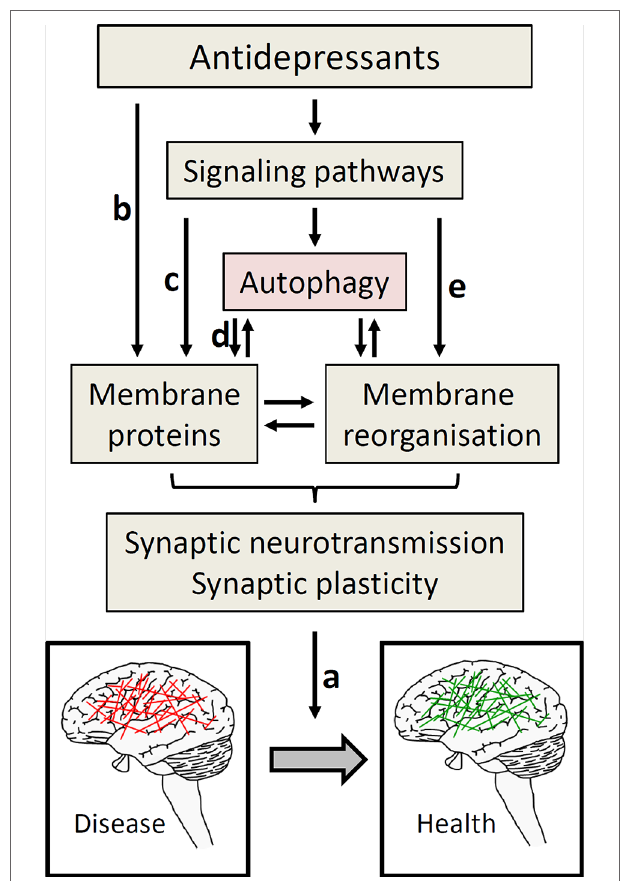
FIGURE 1 | Autophagy as part of antidepressant action. To move from diseased (depressed) to healthy state, ultimately a change in neuronal activity is required (A). To achieve this, several ways of antidepressant actions are proposed including effects on hormonal systems, immune system, and neurogenesis, which all might be intertwined with autophagy (97); this figure focuses on synaptic neurotransmission. The by far most often described effect of antidepressants on synaptic neurotransmission operates through directly blocking neurotransmitter reuptake transporters (part of the membrane proteins, (B). These transporters may also be addressed through signaling pathways that regulate their expression and/or function (C), not part of this review). The role of autophagy in antidepressant action frequently is explained by maintaining protein homeostasis in general, and the functional integrity of membrane proteins involved in synaptic neurotransmission in particular (D). These membrane proteins comprise not only transport proteins, but also, e.g., presynaptic SNARE proteins engaged in neurotransmission. Given the similarity of membrane dynamic